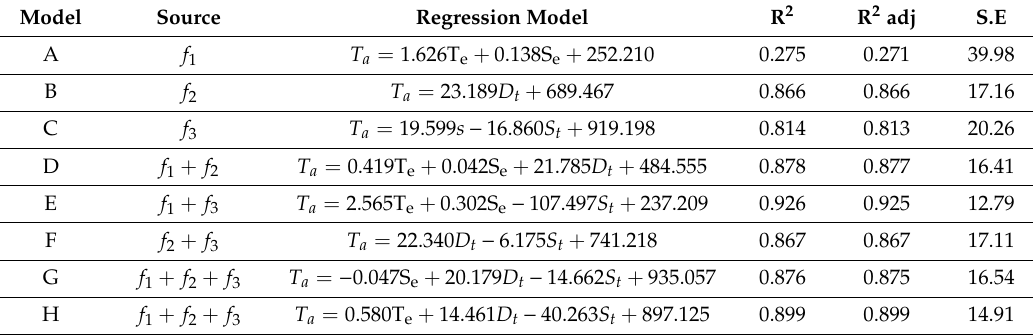
Table 6. Regression model for predicting the axle torque of the tractor.